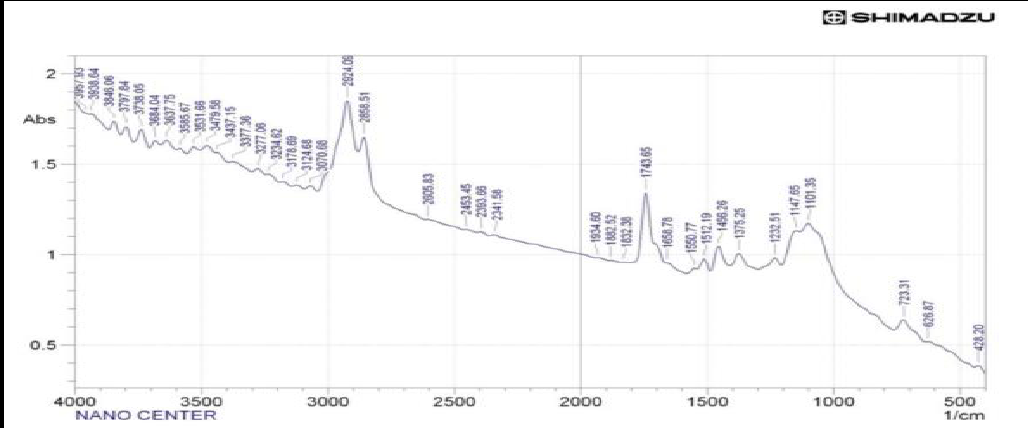
Figure13.FTIR spectrum of floating microparticles (selected formula F16)